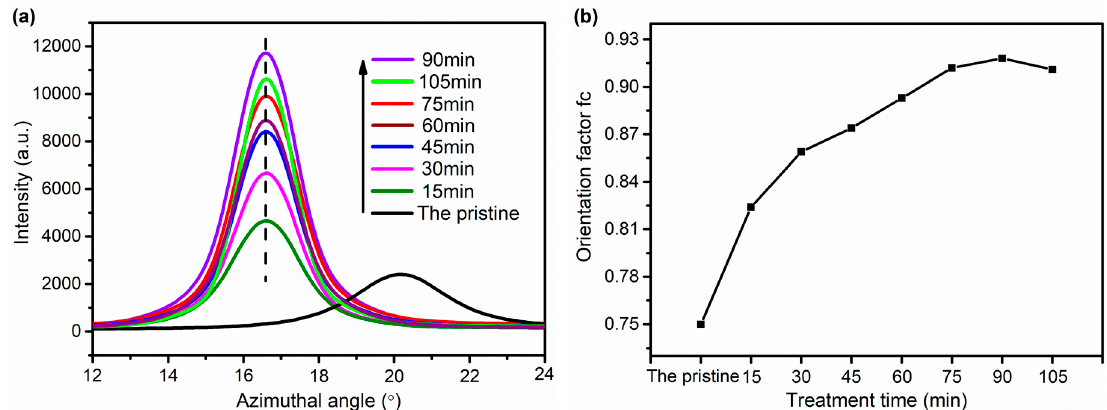
Figure 10. Azimuthal scan curves ( a ) and orientation factors ( b ) of the (110) crystal plane of F-III fibers before and after hot-drawing treatment in Sc-CO 2 .